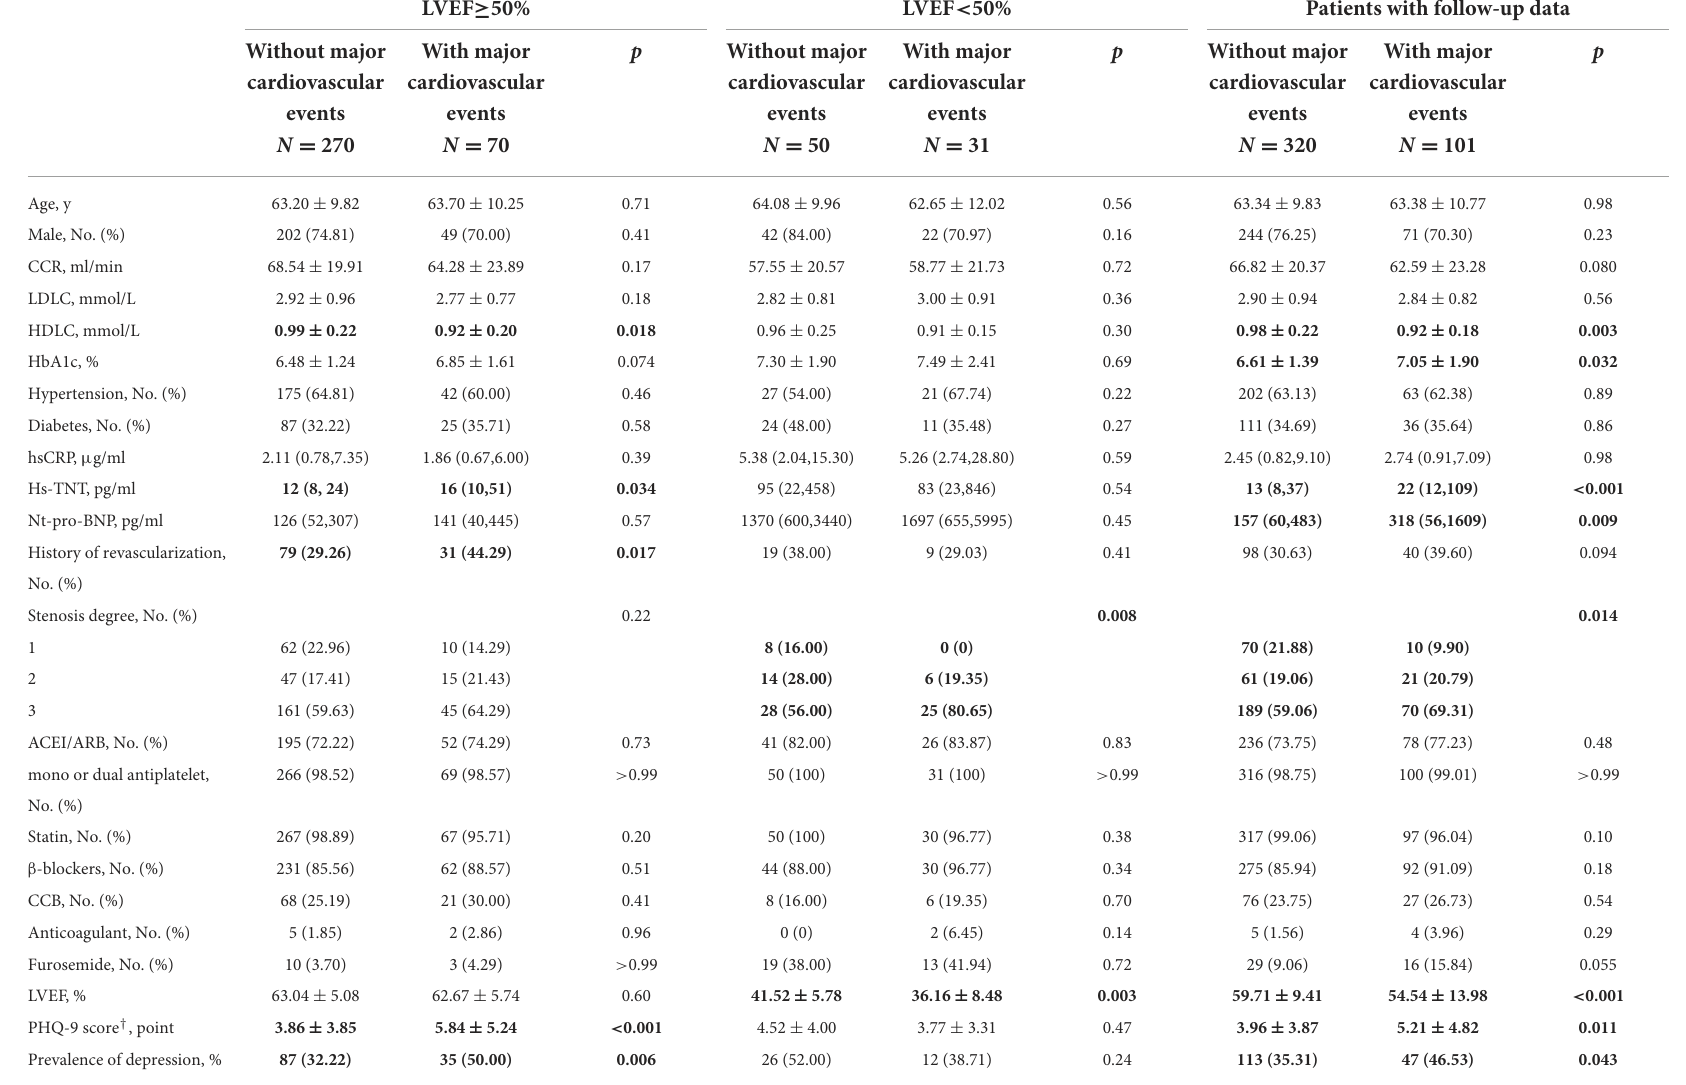
Without major cardiovascular